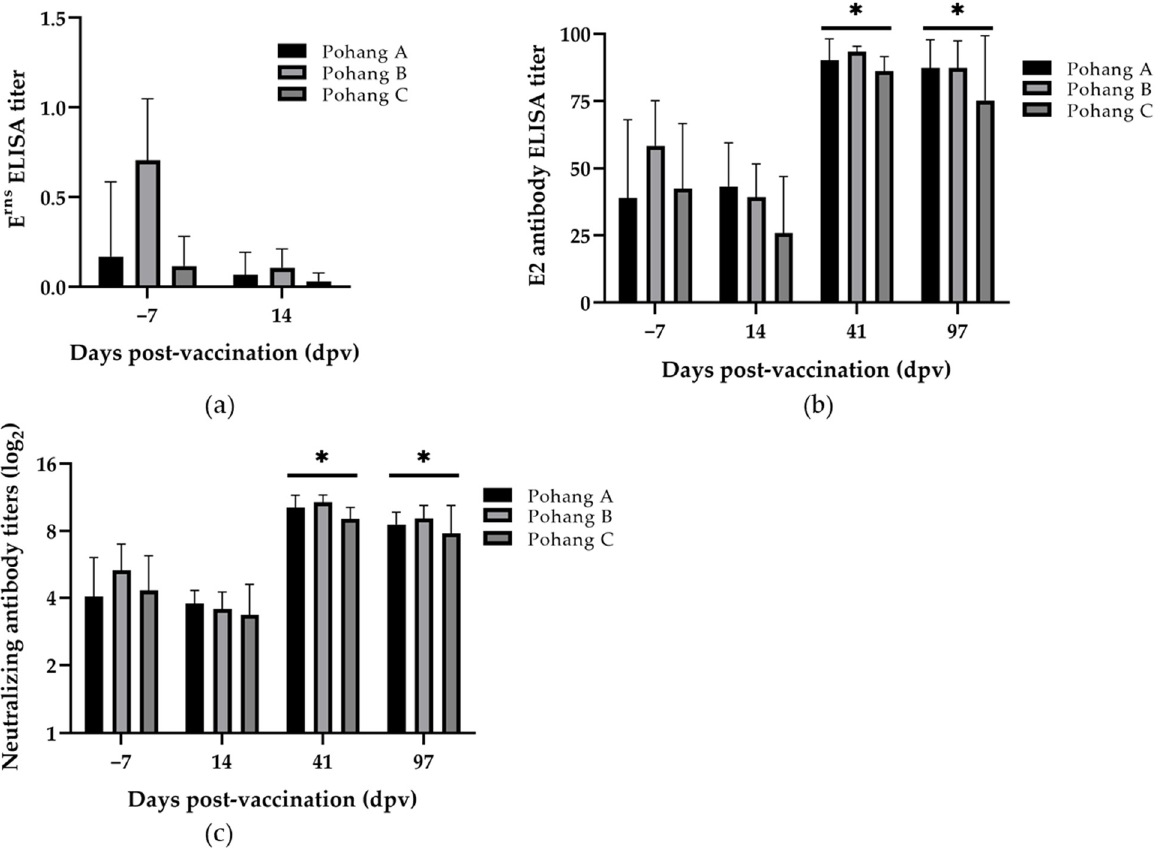
Figure 4. Serological analysis of serum samples from piglets on farms in Pohang. Erns-specific ELISA ( a ), E2-specific ELISA ( b ), and neutralizing antibody titers ( c ) were presented from the sera collected at different time points. Bars represent the mean ± standard deviation (SD) during animal experiment period. * p < 0.05.